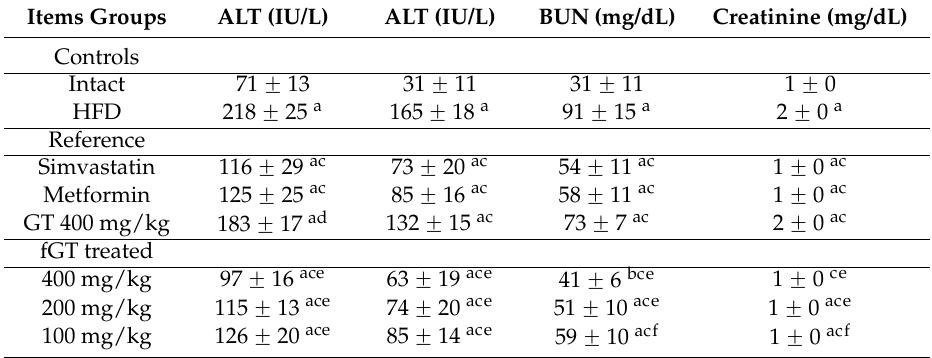
Table 7. Changes in serum AST, ALT, BUN and creatine levels in NFD or HFD supplied